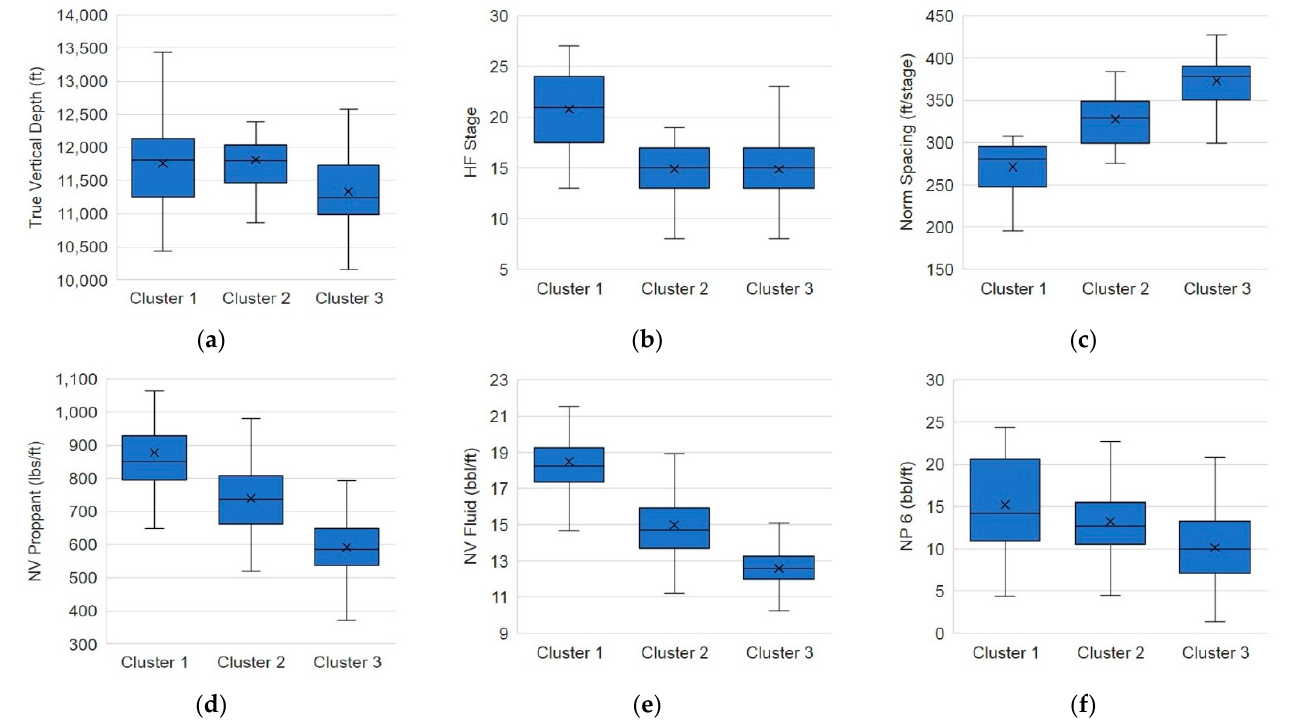
Figure 13. Variable distribution of the three groups based on key factors: ( a ) the TVD; ( b ) the HF stage; ( c ) the norm spacing; ( d ) the NVP; ( e ) the NVF; ( f ) the NP6.